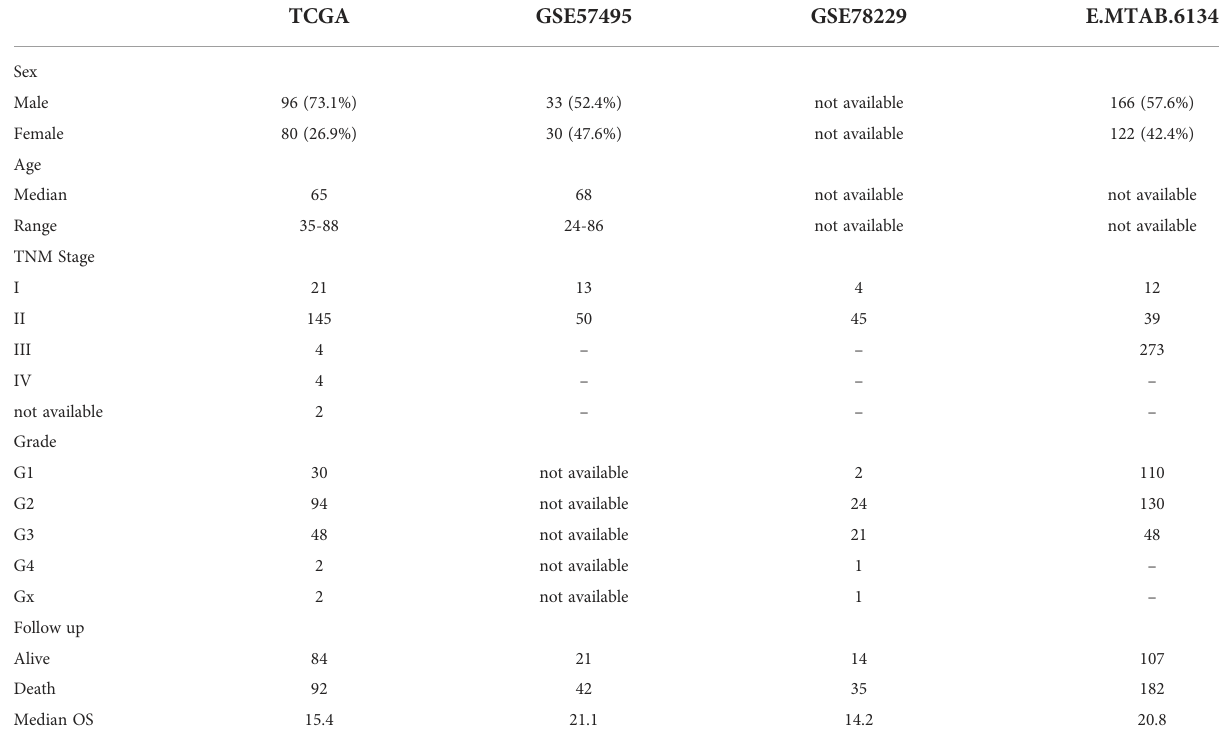
TABLE 1 Clinical characteristics of the cohorts included in this